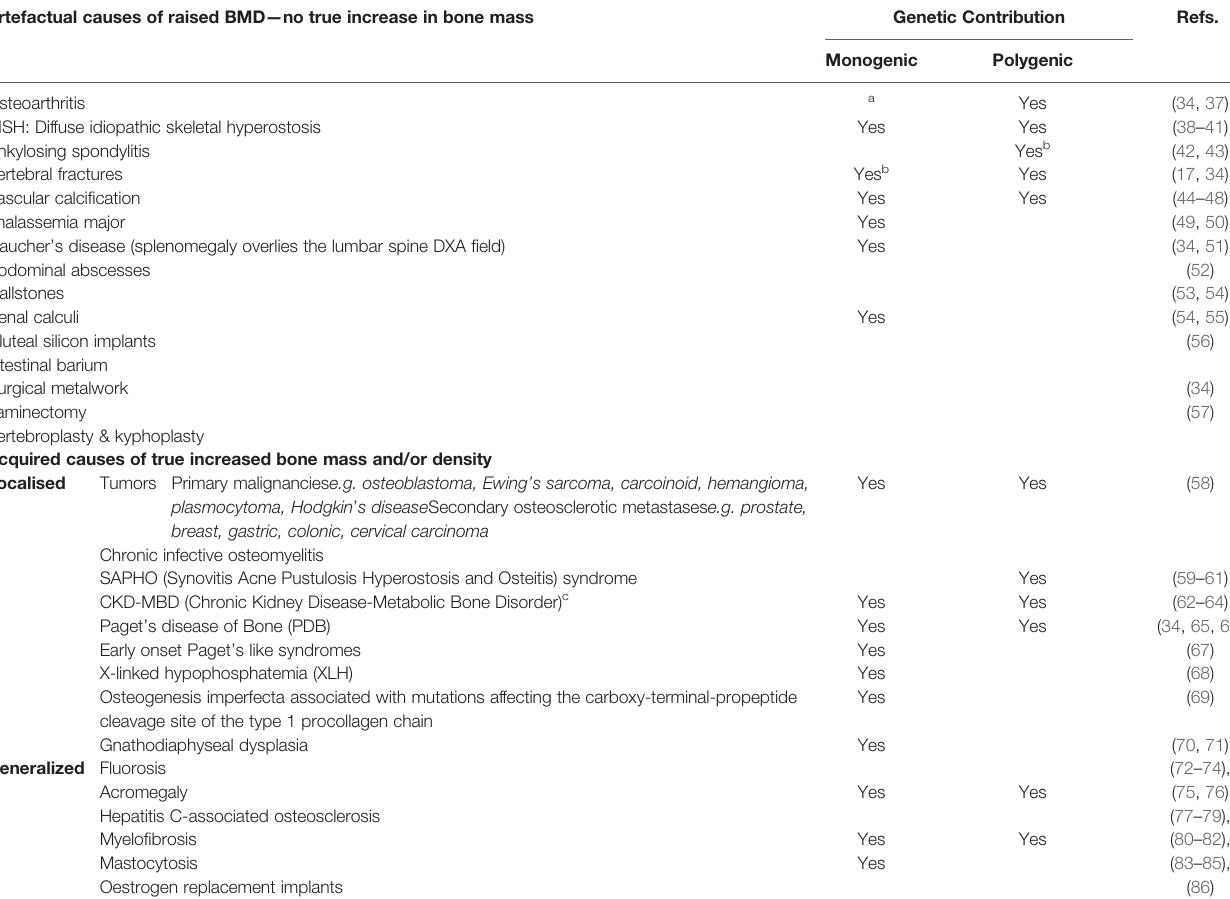
TABLE 1 | Causes of a high BMD measurement on a DXA